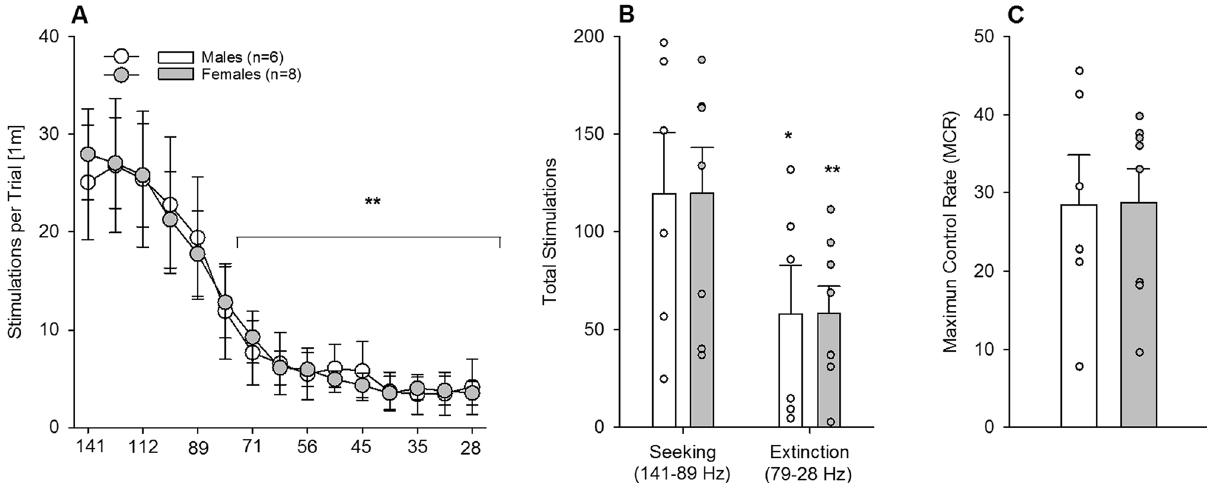
Figure 8. Characterization of brain reward sensitivity in male (n = 6) and female (n = 8) mice (Experiment 4). ( A ) Following ICSS training males (white circles) and females (grey circles) underwent the testing of 15 descending frequencies and all mice showed the expected frequency-dependent decrease in the number of stimulations per trial, which became significant from the 6th frequency on. ( B ) Both seeking (first 5 frequencies) and extinction (remaining 10 frequencies) components were almost identical in all mice, which were characterized by a decrease in the extinction phase, compared to the seeking phase. ( C ) Likewise, all mice also showed an indistinguishable reinforcement rate (males, white bars; females, grey bars). All data represent mean ± SEM. (*) and (**) indicate P < 0.05 and P < 0.01 versus first 5 frequencies ( A ) or seeking ( B ),